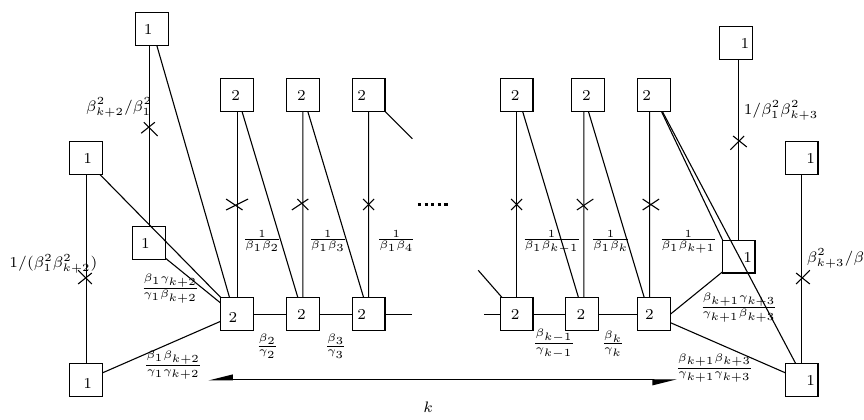
Figure 26 . The tube with all plus boundary conditions. We only show the charges for horizontal lines, which are the M i , and for the (cid:13)ipped (cid:12)elds. The other charges are determined by the triangular superpotentials. Here (cid:13)avor groups denoted by 2 are SU(2 N ) and by 1 are SU( N ). Note that for N = 1 the (cid:13)ip and (cid:13)ipped (cid:12)elds on the edges form mass terms and decouple. The two